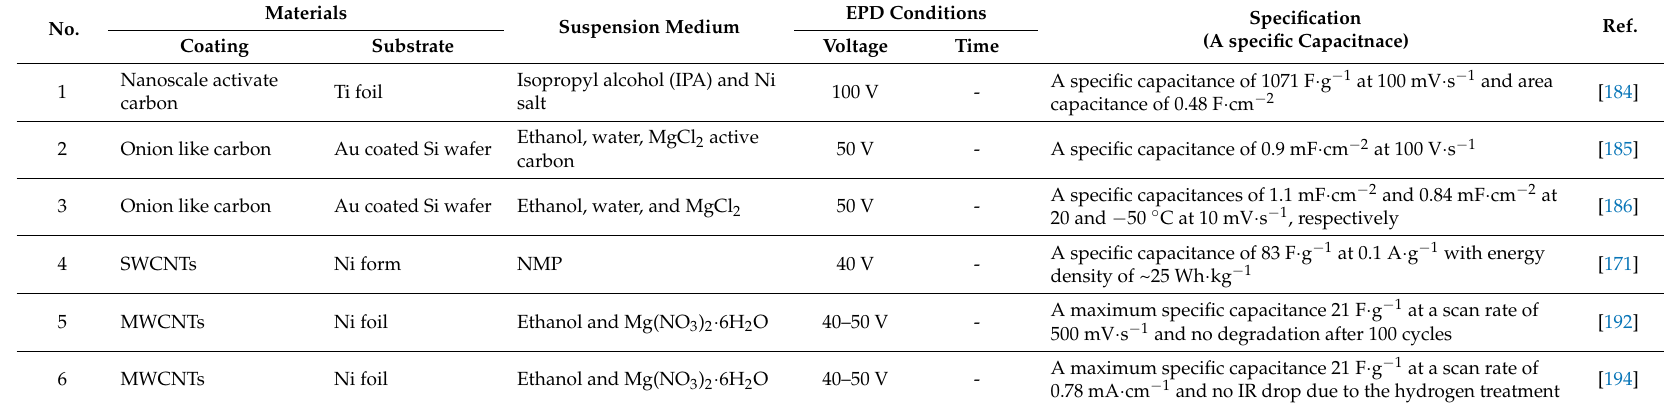
Table A3. Overview of the electrodes fabricated by EPD showing the nanomaterials for supercapacitors and EPD conditions investigated.